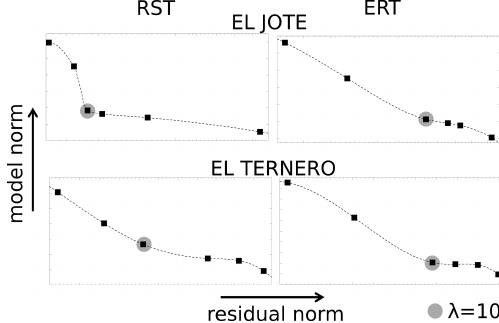
Figure 3. L-curve analysis for the regularization weights ( λ ) used in the inversion of ERT and RST data on both rock glaciers. In each plot, the values tested are λ = 1, 5, 10, 15, 50 and